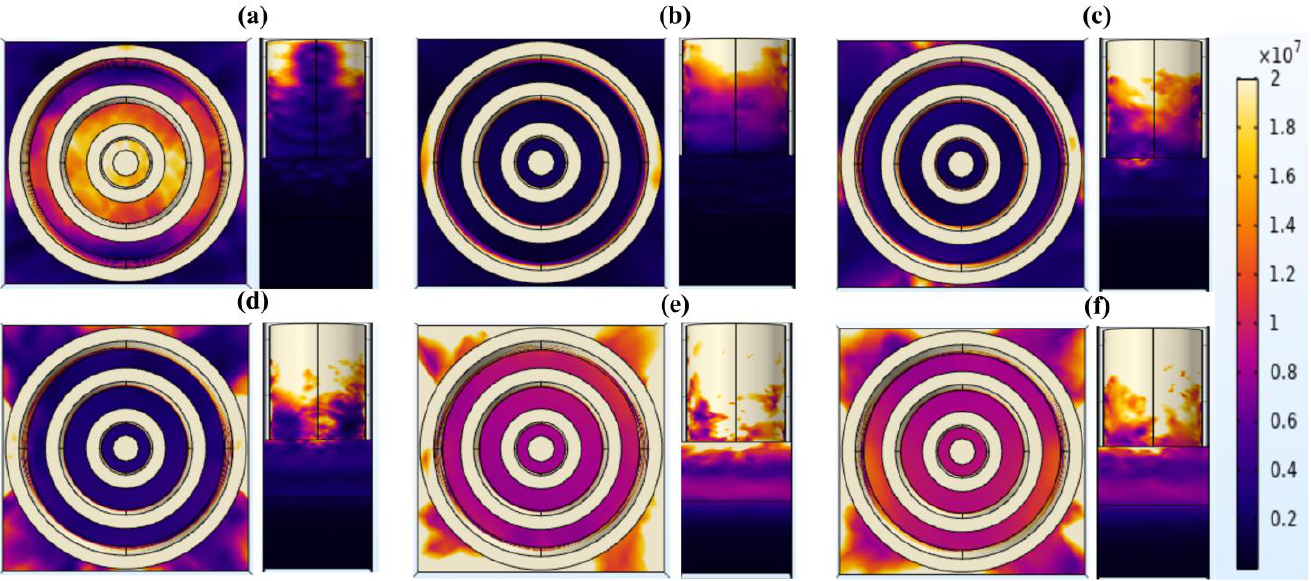
Figure 8. The amount of electric field strength in x-y and x-z planes of GST ring resonators at six peak wavelengths in micrometers (µm). ( a ) λ 1 = 0.25, ( b ) λ 2 = 0.61, ( c ) λ 3 = 1.24, ( d ) λ 4 = 1.84, ( e ) λ 5 = 2.53, and ( f ) λ 6 = 2.91. peak wavelengths in micrometers ( ( e ) λ 5 = 2.53, and ( f ) λ 6 =